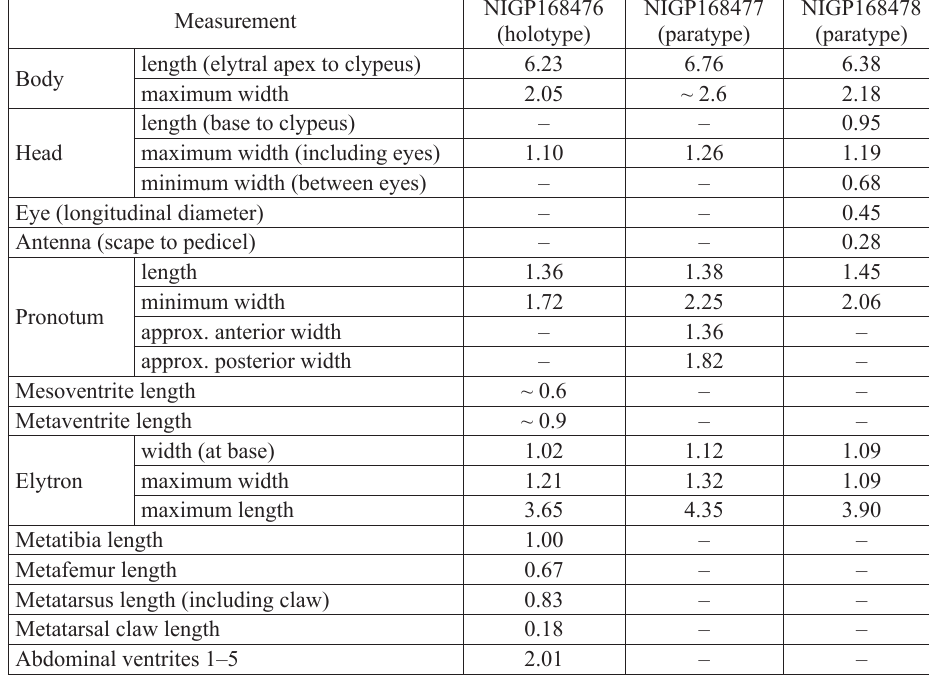
Table 2. Measurements (in mm) of visible body parts in Sinomelyris praedecessor gen. et sp.